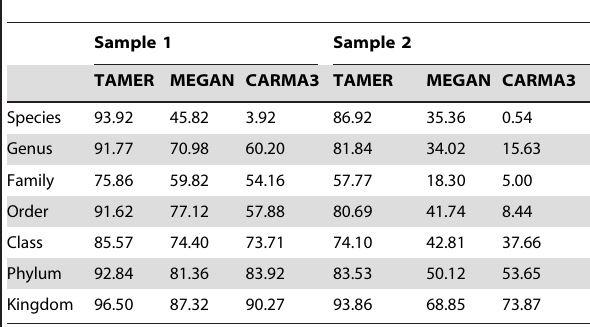
Table 3. Results for the two seawater